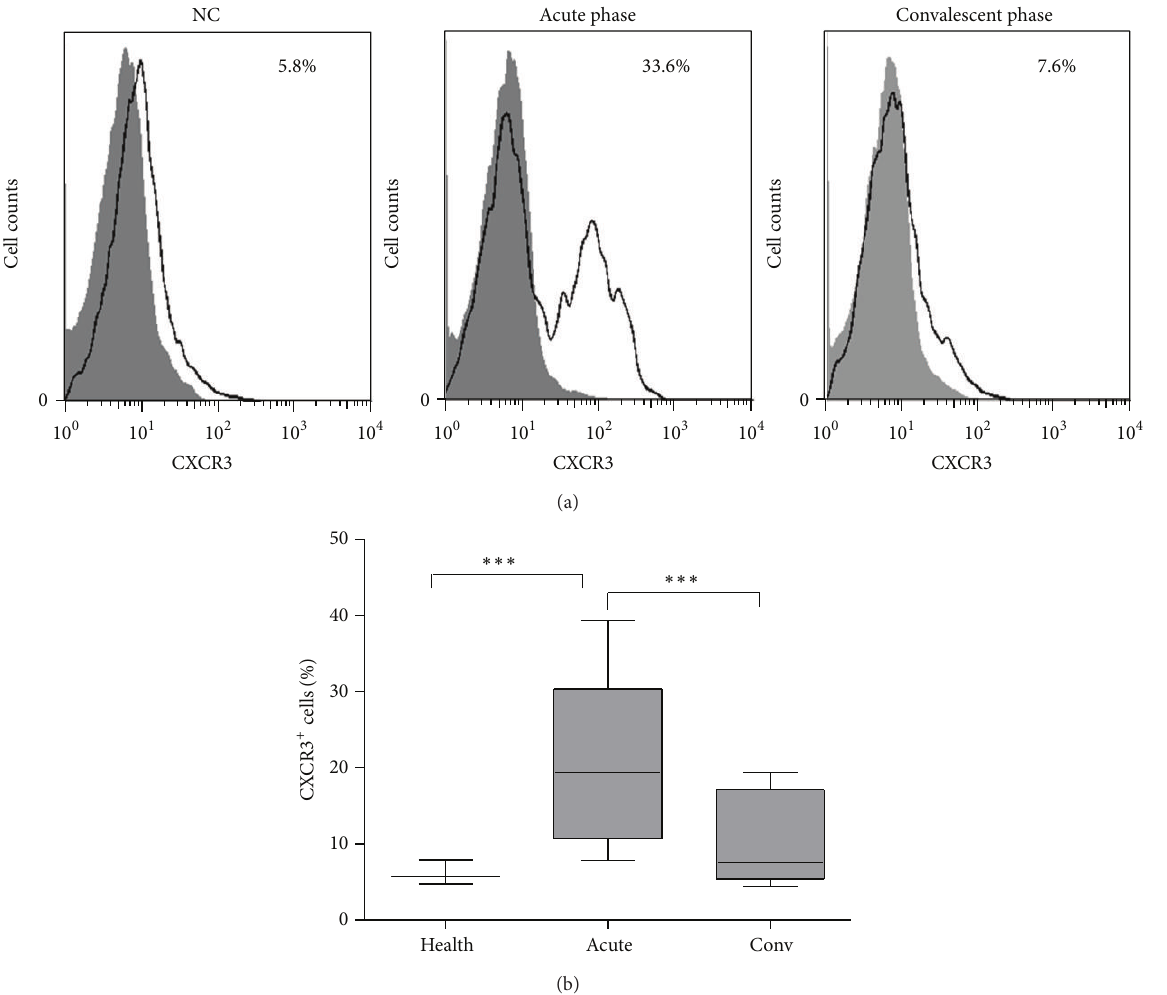
Figure 2: The expression level of CXCR3 increases highly in acute phase of HFRS . (a) The levels of CXCR3 expression on CD14 + subsets in PBMCs were measured by flow cytometry. The CD14 + cells were gated. The expressions of CXCR3 on CD14 population were presented from a healthy donor (NC), a HFRS patient suffering firstly from acute phase, and then from the convalescent phase, respectively. Shaded histograms represented the isotype controls; black lines represented the expression of CXCR3 on CD14 gated PBMCs. The percentage of CXCR3 + cells in the CD14 + subsets was indicated in each graph. (b) The percentages of CD14 + CXCR3 + cells in all the CD14 + subsets in PBMCs were shown in different groups. Values that are statistically different ( 𝑃 < 0.001 ) between NC and acute phase or between acute phase and convalescent phase are indicated ( ∗∗∗